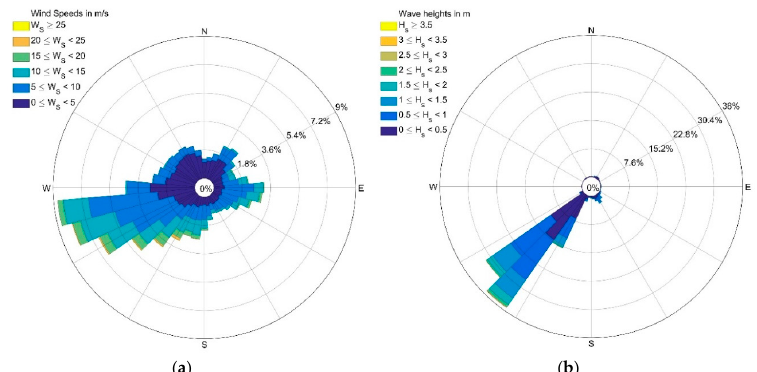
Figure 2. ( a ) A wind rose taken from the Mumbles weather station, operated by the UK Meteorological Office; ( b ) A wave rose from a wave buoy situated in the centre of Swansea Bay. Data taken for the duration of the drone-based surveys (October 2018—December 2019).